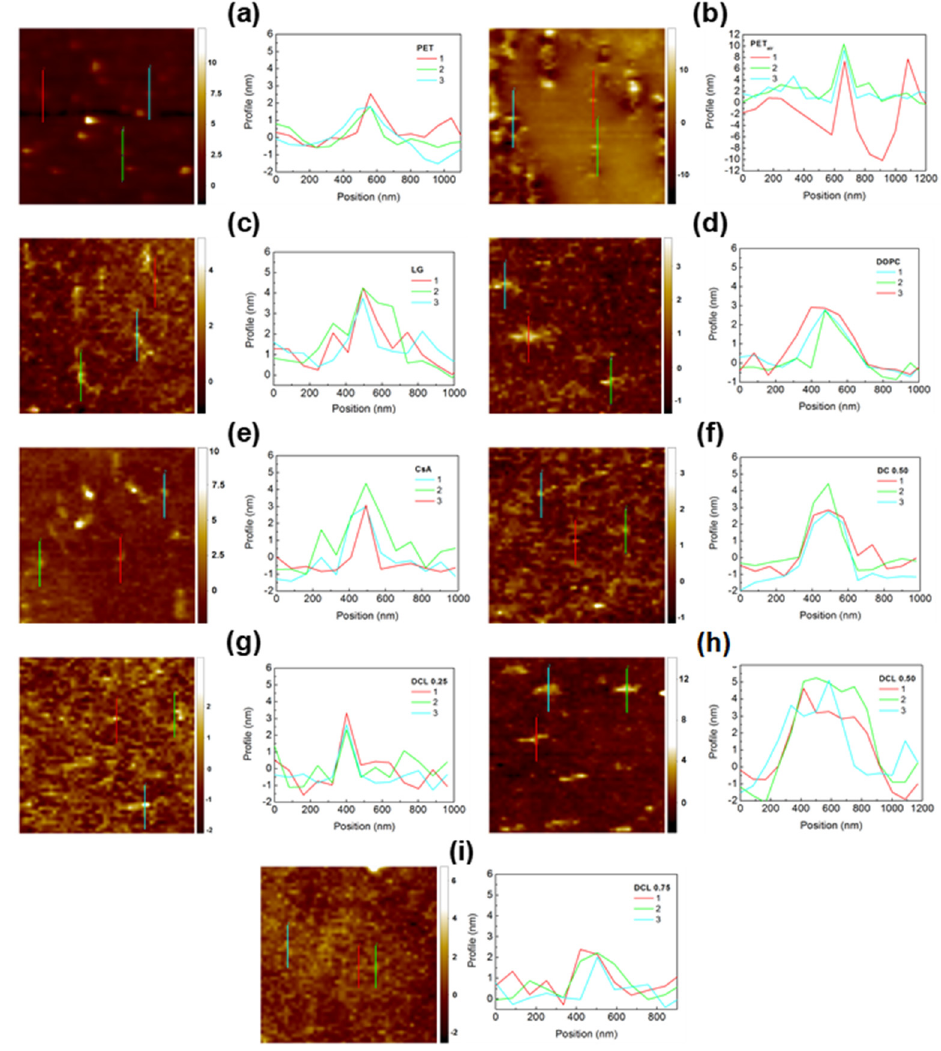
Figure 4. AFM zoomed micrographs and profiles obtained for: PET ( a ), PET air ( b ), PET air /LG ( c ), PET air /DOPC ( d ), PET air /CsA ( e ), PET air /DOPC-CsA 0.50 ( f ), PET air /DOPC-CsA-LG 0.25 ( g ), PET air /DOPC-CsA-LG 0.50 ( h ), PET air /DOPC-CsA-LG 0.75 ( i ). Z scale: nm.